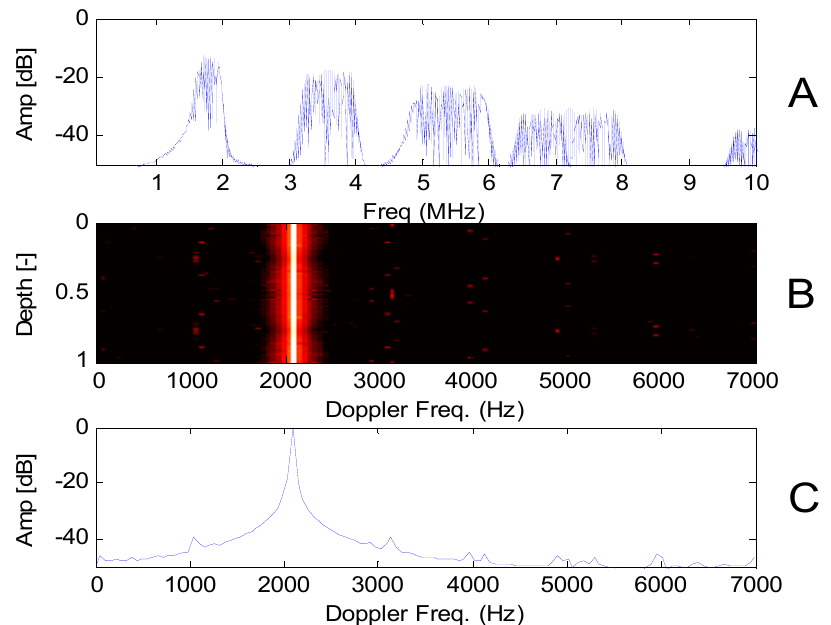
Figure 4. Simulation of the noise produced by a switching regulator modulated with a triangular frequency between 1.6–2.0 MHz in an acquisition with T Pri = 142.86 µ s. ( A ) Spectrum of the noise as input to the Doppler system; ( B ) Doppler spectral matrix; ( C ) spectral density averaged over depths